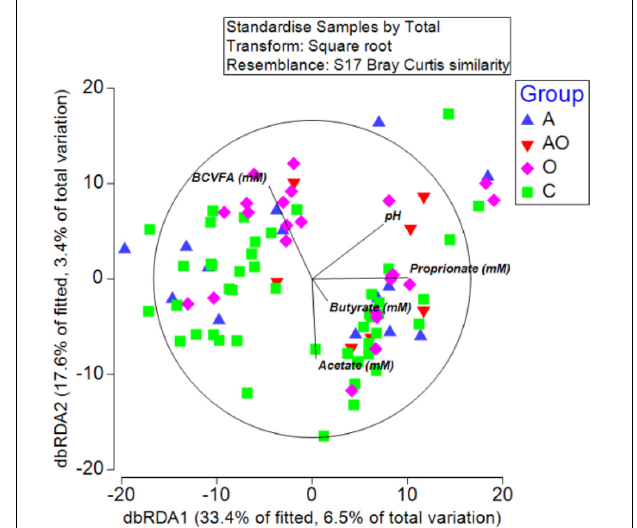
FIGURE 5 | Distance-based redundancy analysis illustrating associations between microbiome and fecal metabolome measures (branched chain volatile fatty acids (BCVFA), concentrations (mM) of acetate, butyrate and propionate and fecal pH) in aged (A), aged and obese (AO), obese (O), and control (C)